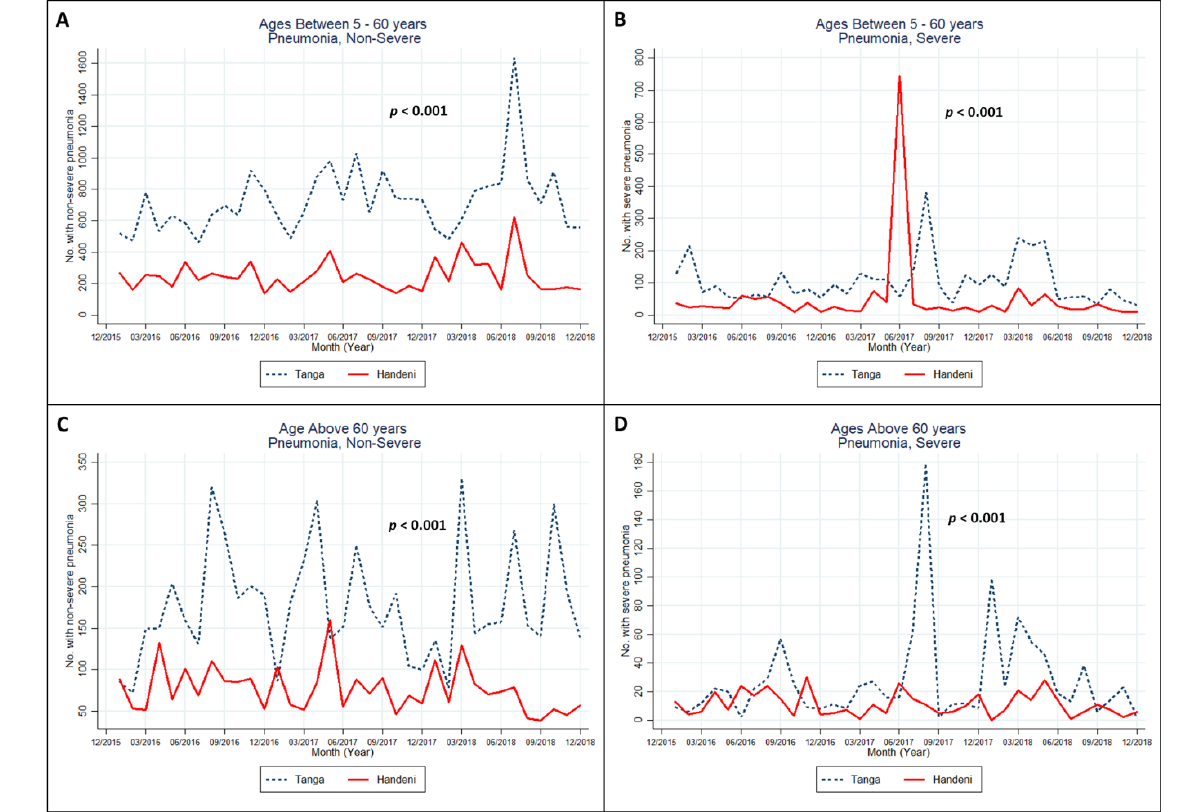
Figure 3. Monthly non-severe ( A , C ) and severe ( B , D ) pneumococcal infections of the age groups of 5 years old across 2016 to 2018 in Tanga, Tanzania. Note : multilevel mixed-effects Poisson regression—with levels 1 and 2 being month and year, respectively—was used to test the trend differences.